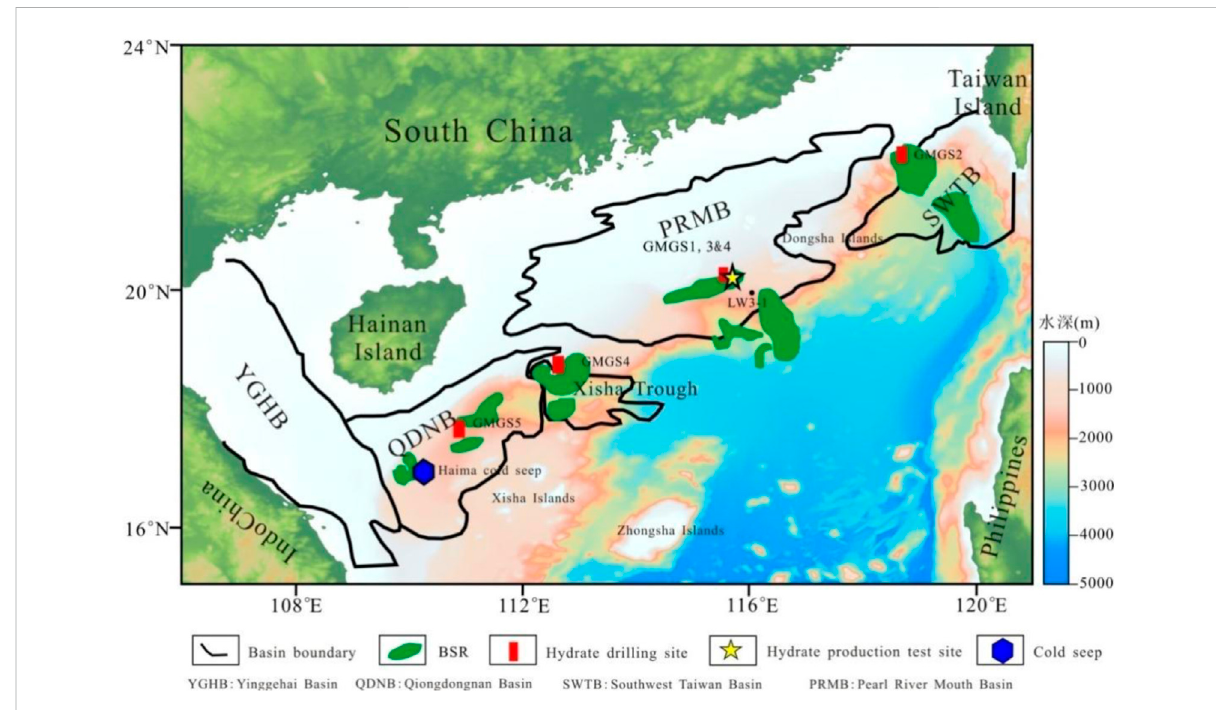
FIGURE 2 Depositional basins and gas hydrate surveying in the northern South China Sea. BSR, bottom simulating re fl ector (modi fi ed from Wu and Wang (2018) and Liang et al.